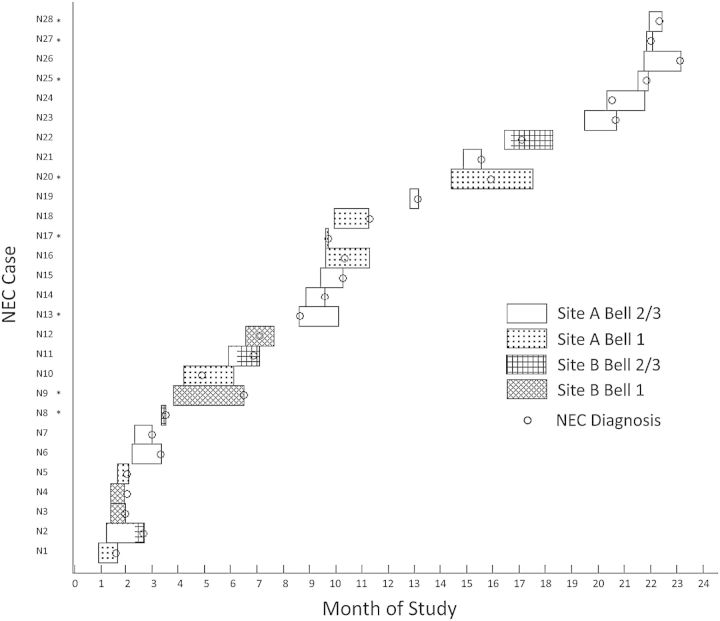
Cumulative cases of necrotizing enterocolitis (NEC) over 24 months. Hatching indicates hospital site and Bell staging. Bar length indicates duration of infant admission on the neonatal unit and circles indicate date of NEC diagnosis. Asterisked cases were excluded from the analyses due to lack of samples (n = 2), sequencing data (n = 4), or controls (n = 2).